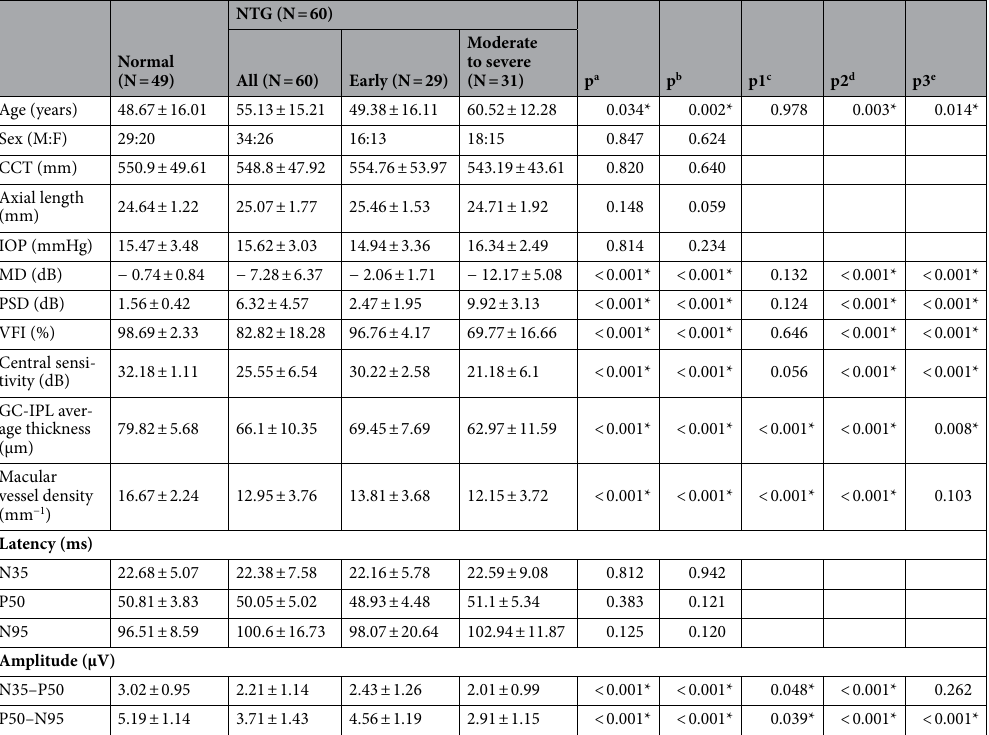
Table 1. Comparison of demographics and clinical characteristics between normal and patients with NTG. Data are presented as mean ± SD or ratio. NTG normal-tension glaucoma, CCT central corneal thickness, all-glaucoma groups. b Analysis of variance or chi-squared test in the normal, early, and moderate to severe glaucoma groups. c–e p1, p2, and p3 show the results of the post hoc analyses. c p1: normal vs . early glaucoma, d p2: normal vs. moderate to severe glaucoma, e p3: early glaucoma vs. moderate to severe glaucoma. *p <